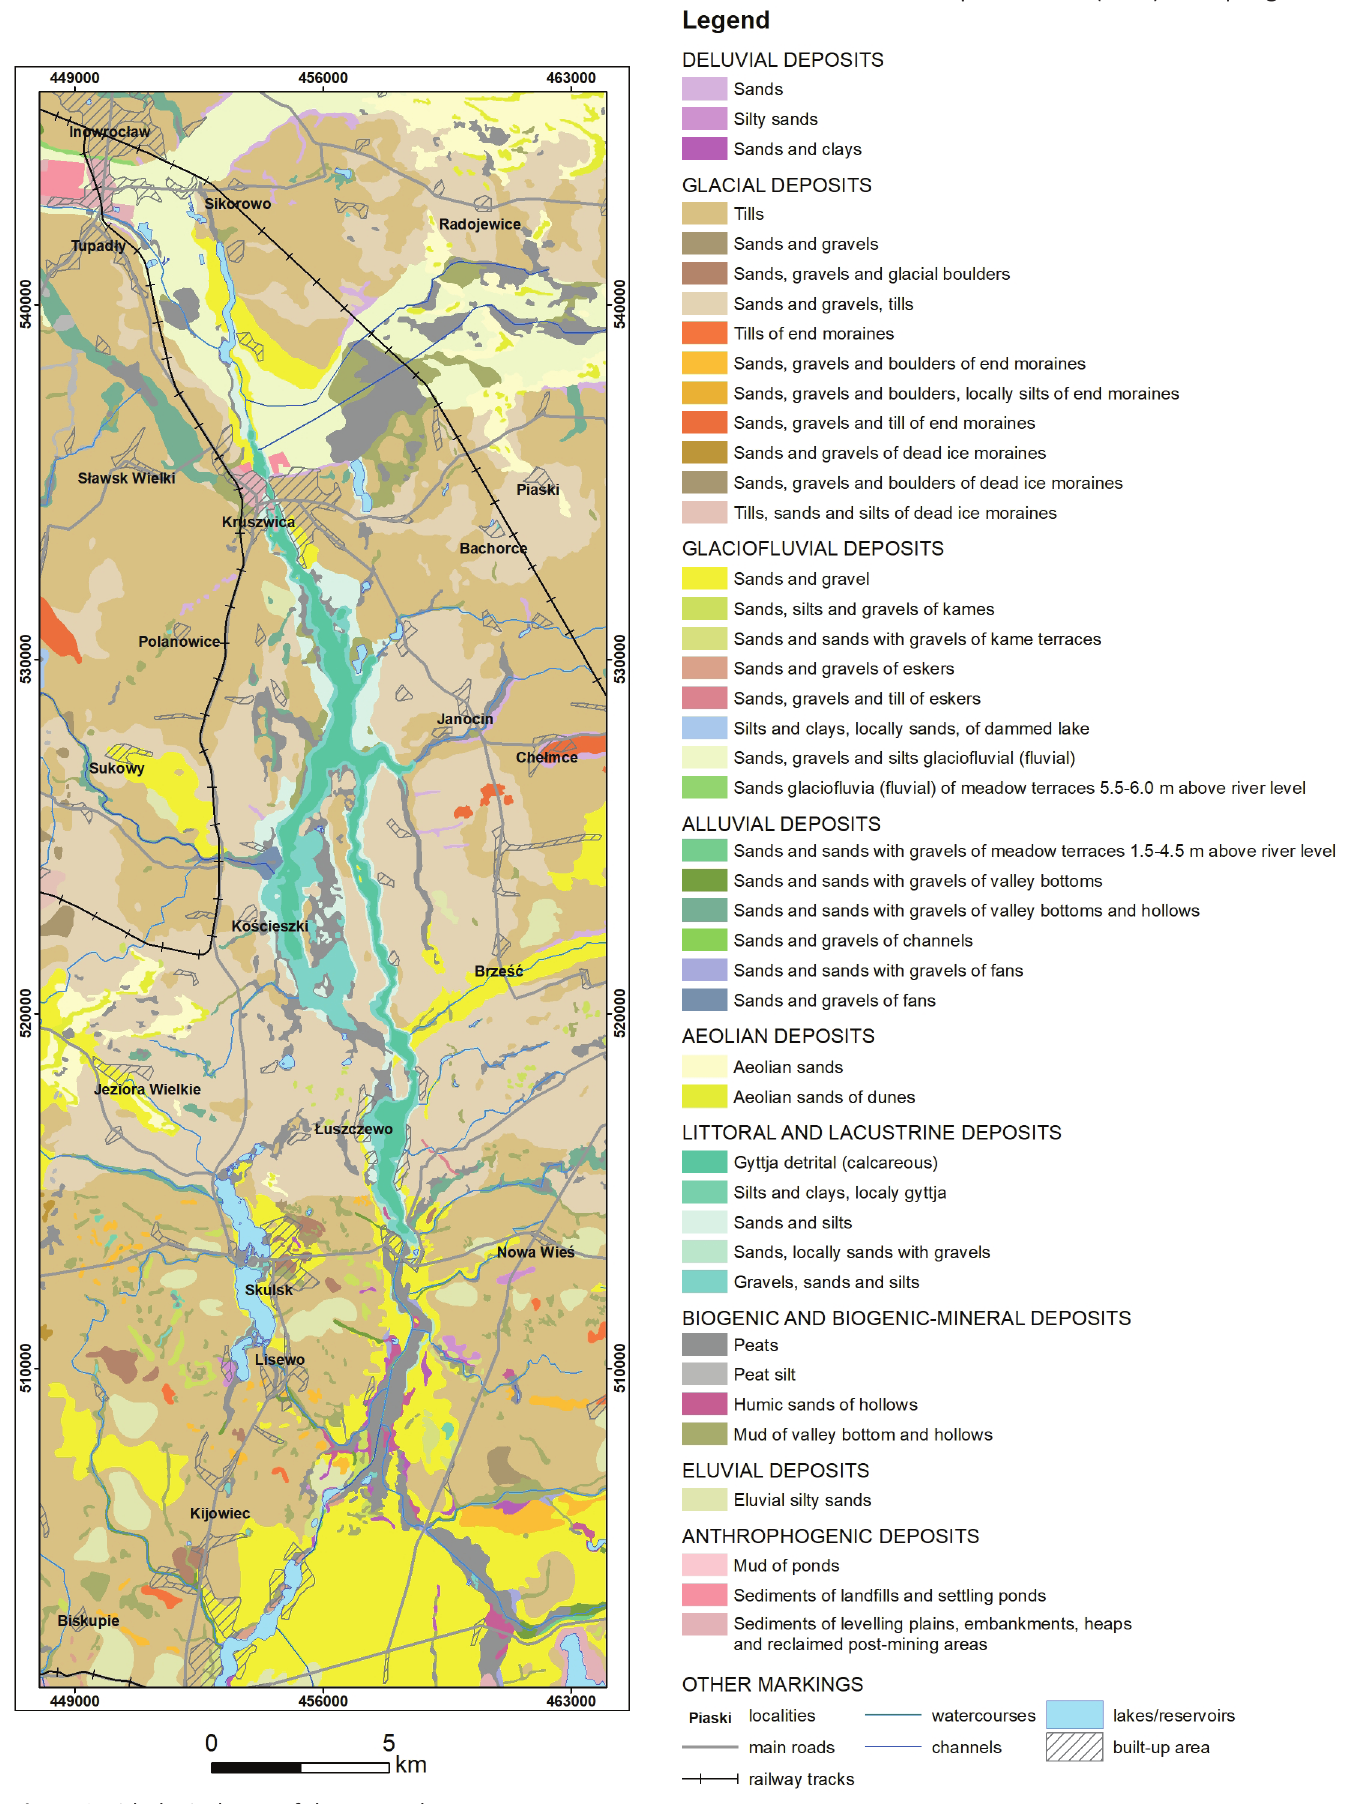
Figure 8. Lithological map of the research